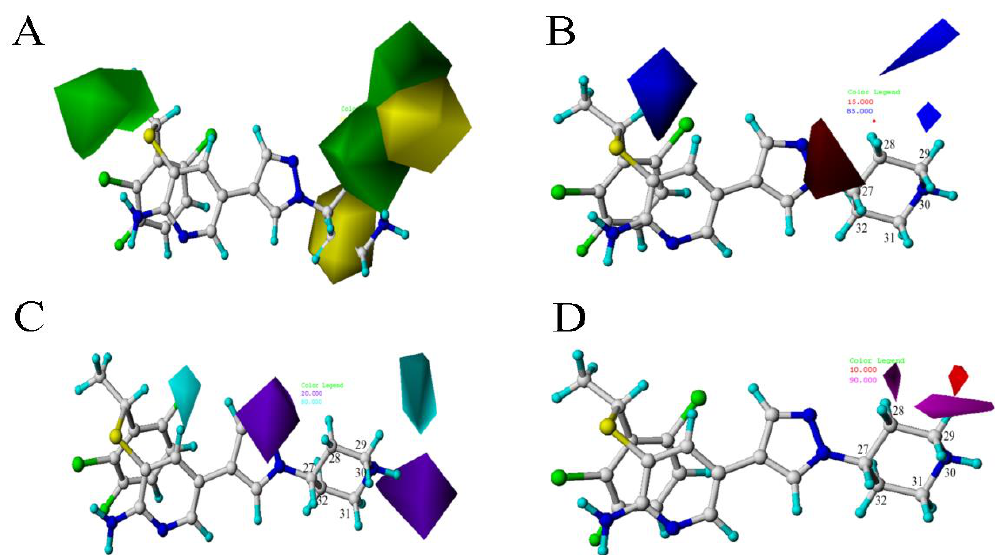
Figure 4. The CoMFA STDEV × COEFF contour maps based on template compound 4 . ( A ) The with group at this position can increase the activity. steric field. ( B ) The electrostatic field.